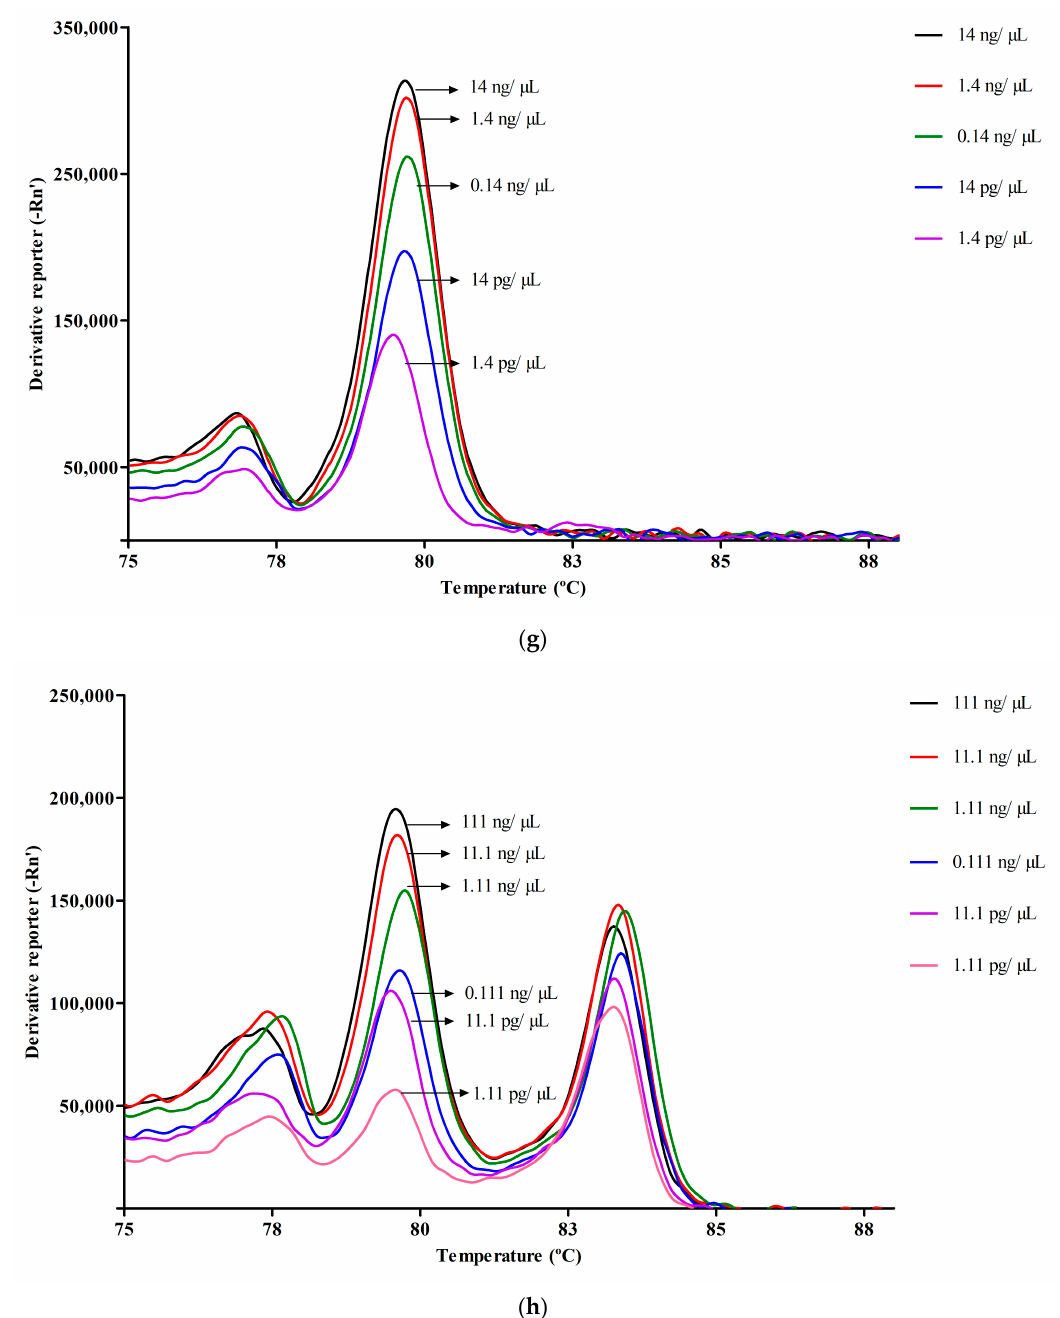
Figure 3. qPCR efficiency with dynamic range and coefficient of determination for E. coli O157 ( a ), Salmonella spp. ( b ) and L. monocytogenes ( c ) in simplex and multiplex ( d ). Curves for each situation were obtained by three replicates of ten-fold serial dilutions of a DNA extract from each pathogen, and a mixture of the three extracts and multiplex experiments. Graphic ( e – h ) represent the melting analysis of the same samples, respectively.